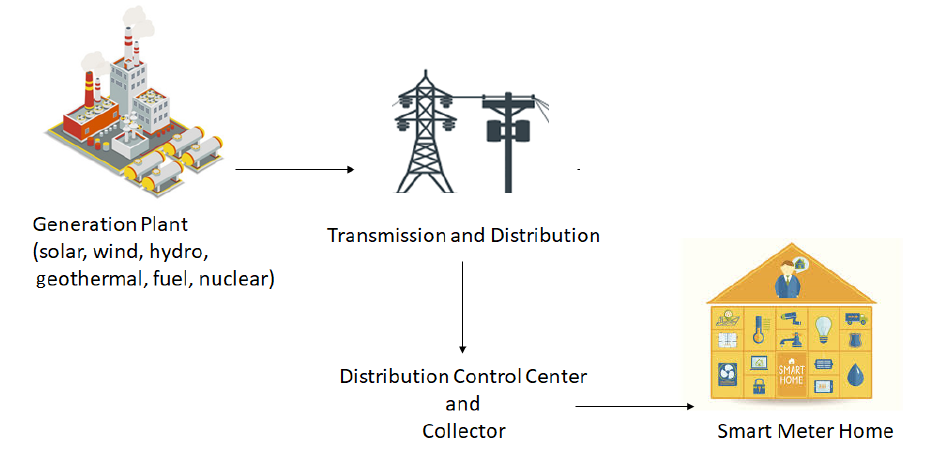
Figure 9. Smart grid